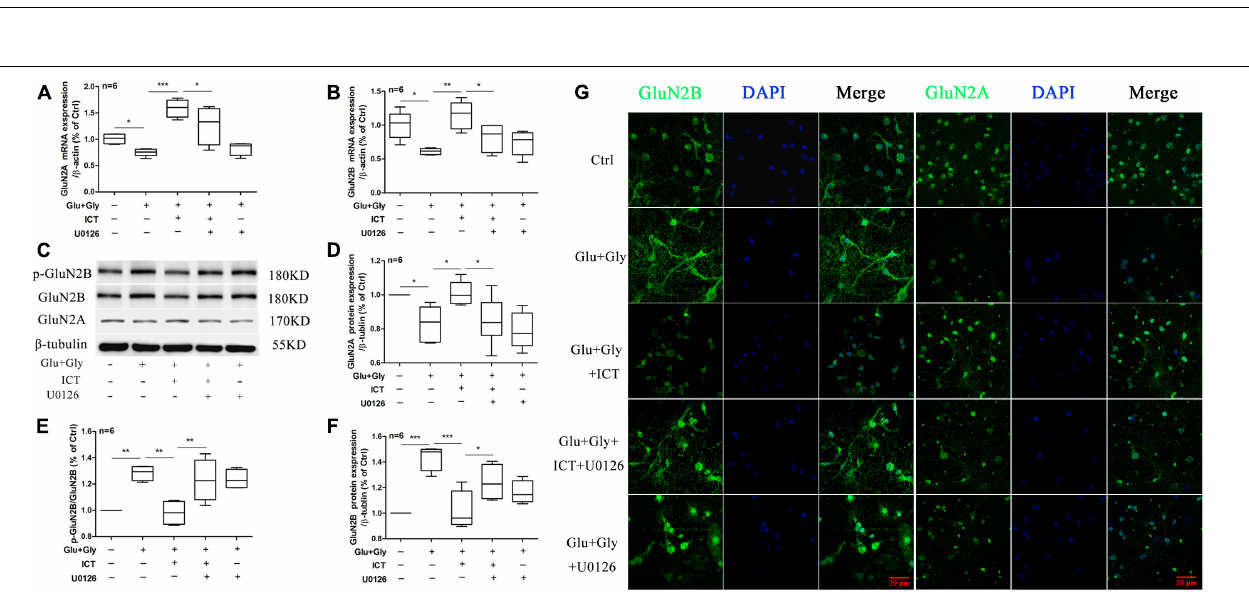
FIGURE 5 | The ability of ICT to regulate GluN2B and GluN2A functions after glutamate-induced neuronal injury is diminished with the inhibition of ERK. Western blot and RT-qPCR were performed to analyze GluN2B and GluN2A mRNA and protein levels (A–F) from the different treatment groups: control, Glu+Gly, Glu+Gly+1 µ M ICT, Glu+Gly+1 µ M ICT+5 µ M U0126, and Glu+Gly+5 µ M U0126; the results are expressed as the mean ± SEM ( n = 6). GluN2B and GluN2A protein localization is shown in the immunofluorescent images (G) . One-way ANOVA followed by Newman-Keuls test, (A) : F = 14.55, (B) : F = 6.921, (D) : F = 7.099, (E) : F = 9.517, (F) : F = 10.39; * p < 0.05, ** p < 0.01, and *** p <